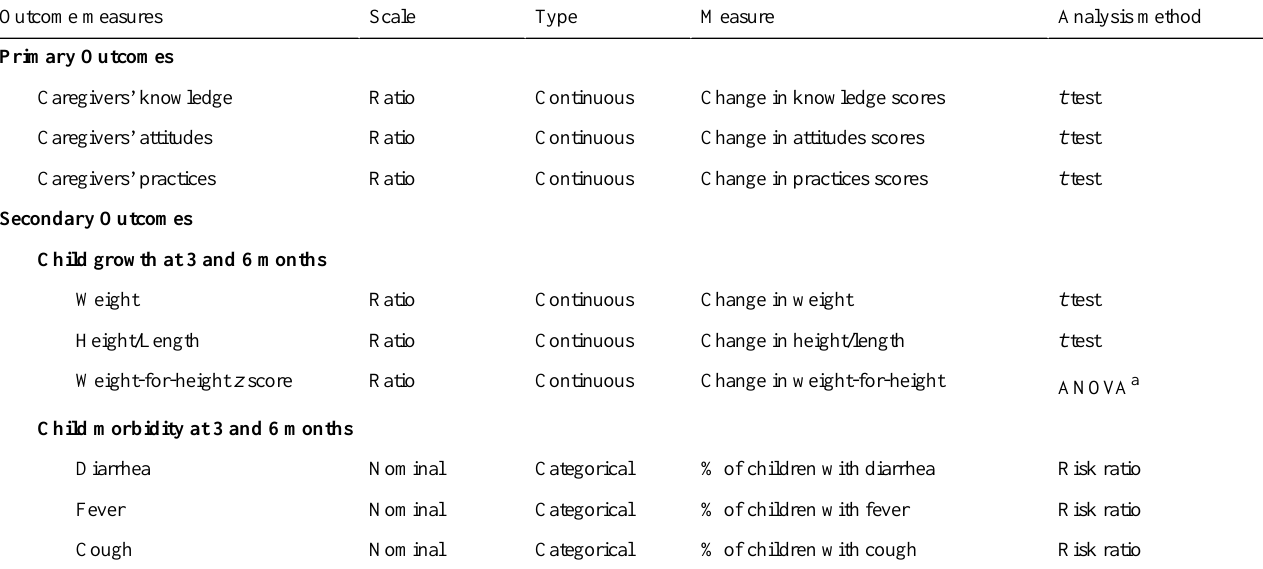
Table 1. Primary and secondary outcome variables among study participants at baseline, 3 months, and 6